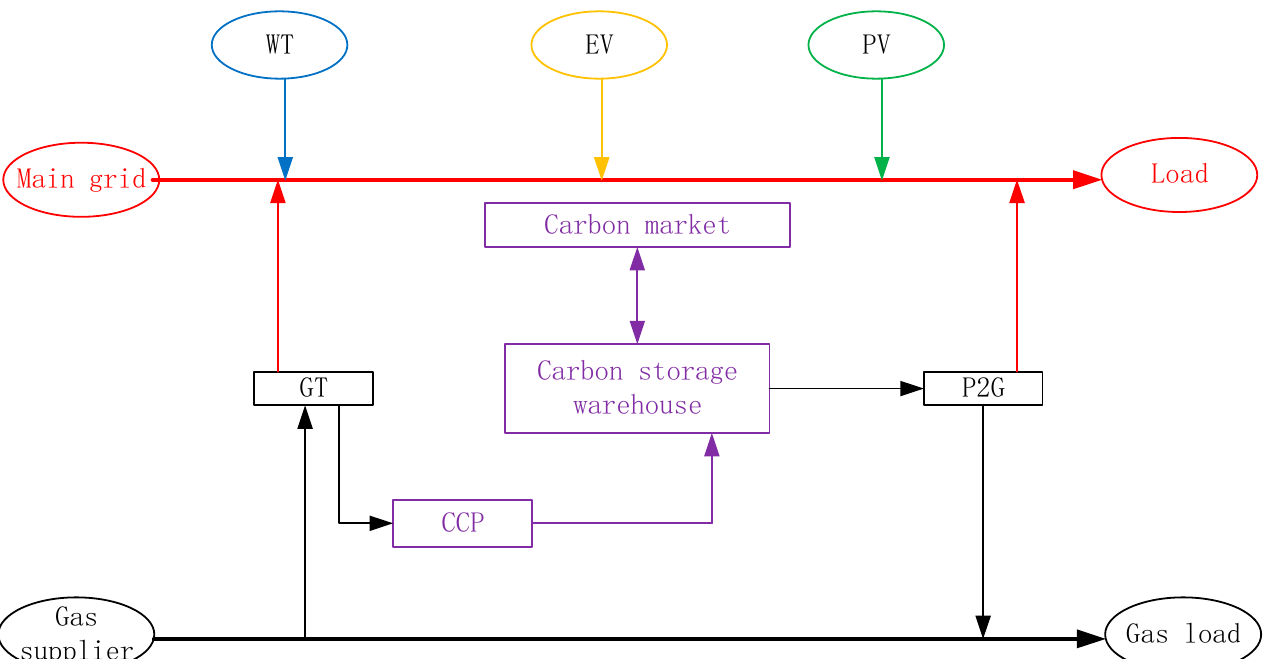
Figure 1. The structure of integrated electricity–gas distribution system.